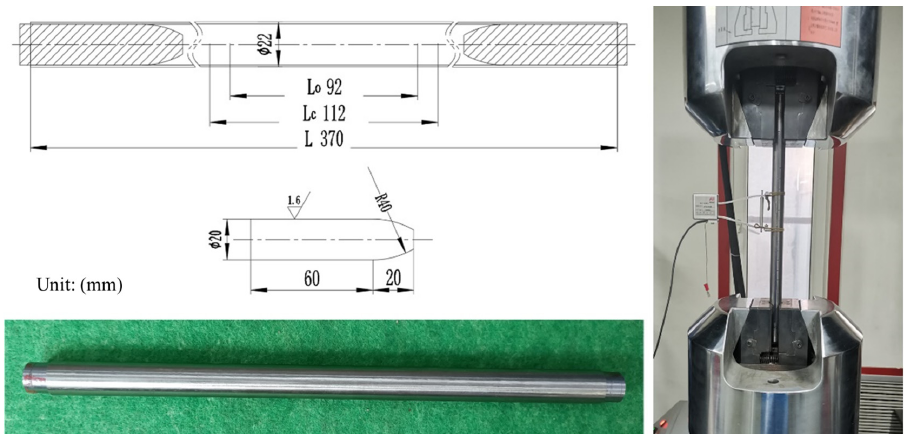
Figure 4. Standard uniaxial tensile test of the SUS304 stainless steel tube. Table 2. The chemical composition of SUS304 stainless steel.